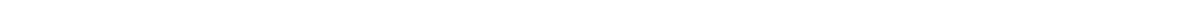
Fig. 5 MYBMIM exhibits anti-leukemia ef fi cacy in vivo. a Activity of burst forming units-erythroid (BFU-E, red) and colony forming units-granulocyte/ monocyte (CFU-GM, black) of CD34 + human umbilical cord progenitor cells treated with control PBS, or 20 μ M TG3 or MYBMIM for 14 days. Error bars represent the standard deviation of 3 biologic replicates. b Representative phase photographs of CFU-GM colonies treated as indicated. c – f Peripheral blood count analysis of C57BL/6 J mice treated for 7 days with MYBMIM (25 mg/kg IP daily), as compared to control PBS. Bars indicate the mean and standard deviation of individual mice. g Plasma concentration of BIO-MYBMIM after one-time IP injection of 25 mg/kg in C57BL/6 J mice. Plasma was collected at 30 min, 2 h, 4 h, and 24 h post-injection and the concentration of BIO-MYBMIM was determined by spectrophotometric avidin assay. h Representative fl uorescent micrographs of human-speci fi c CD45 staining (green) and DAPI staining (blue) in femur sections of NSG mice engrafted with primary patient-derived MLL-rearranged leukemia cells and treated with MYBMIM (25 mg/kg IP daily) as compared to control PBS for 21 days upon development of peripheral leukemia, quanti fi ed in ( i ). Error bars represent standard deviation of 6 individual mice. * p = 1.2e – 4, log-transformed t -test. j Images of fl uorescent micrographs of human BCL2 (green) and DAPI (blue), quanti fi ed in ( k ). Error bars represent standard deviation of 6 individual mice. * p = 0.3, log-transformed t -test. l Kaplan – Meier survival analysis of NSG mice engrafted with primary patient-derived MLL-rearranged leukemia cells and treated 3 days post transplantation with MYBMIM (red, 25 mg/kg IP twice daily) as compared to control PBS (black) for 14 days. n = 15 mice per group. p = 0.0038, log-rank test. m Kaplan – Meier survival analysis of NSG mice serially transplanted with bone marrow collected from moribund mice engrafted with primary patient-derived MLL-rearranged leukemia cells treated with MYBMIM for 14 days. n = 10 mice per group. p < 0.0001, log-rank